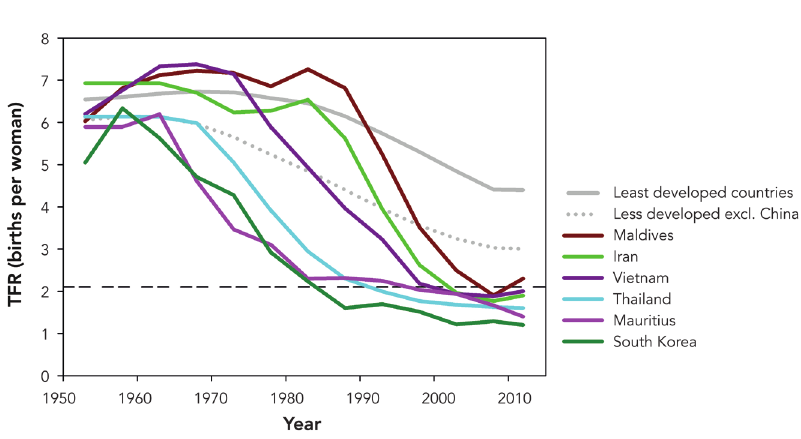
Figure 4. Time course of total fertility rate (TFR, births per woman) for selected countries which implemented population-focused voluntary family planning programmes at differing times, showing rapid change in fertility, compared with aggregate TFR for less developed and least developed nations. Data from UNDESA (2011) and Population Reference Bureau World Population Datasheet